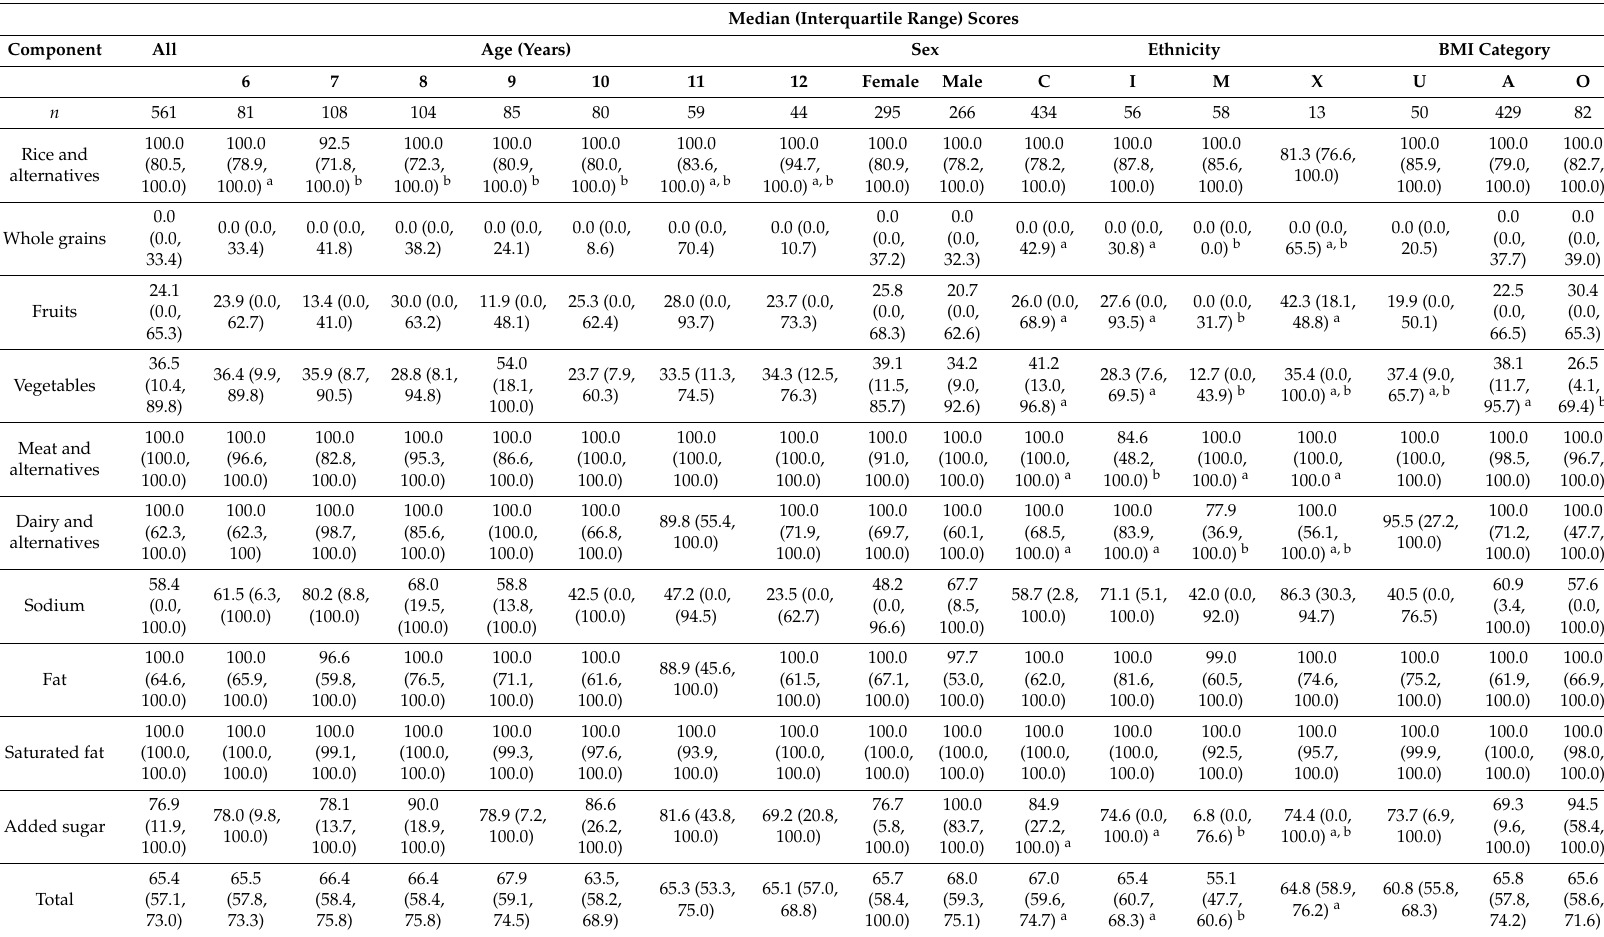
Table 1. Median (interquartile range data) for individual components and total diet quality scores by demographics and BMI category. Median (Interquartile Range)